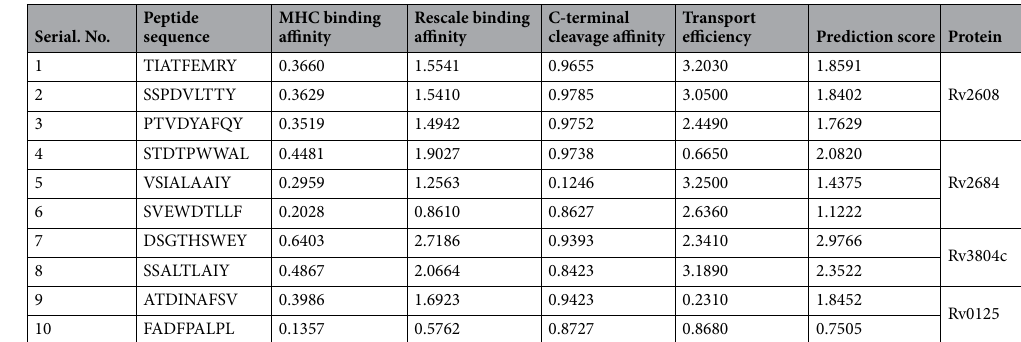
Table 1. List of the selected CTL epitopes which have fulfilled all the criteria for antigenicity, non- allergenicity, non-toxicity and could bind efficiently to MHC-I A1-supertype alleles.